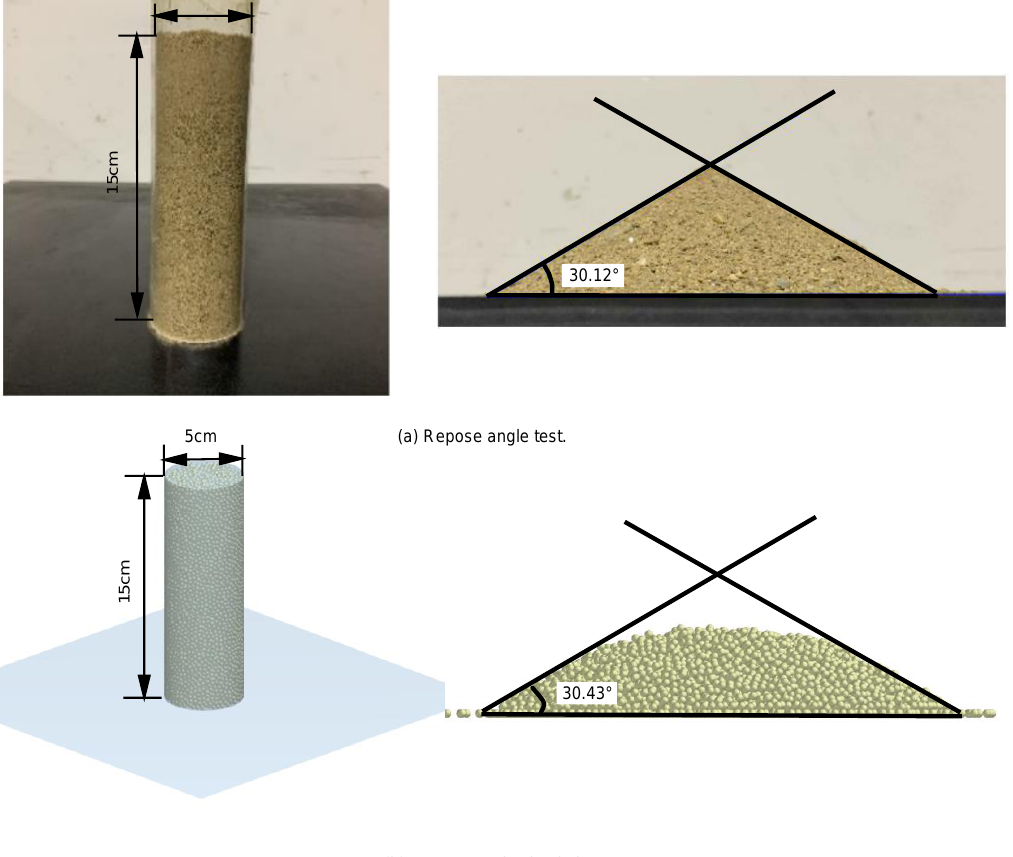
Figure 4. Repose angle model test [29] and simulation test.